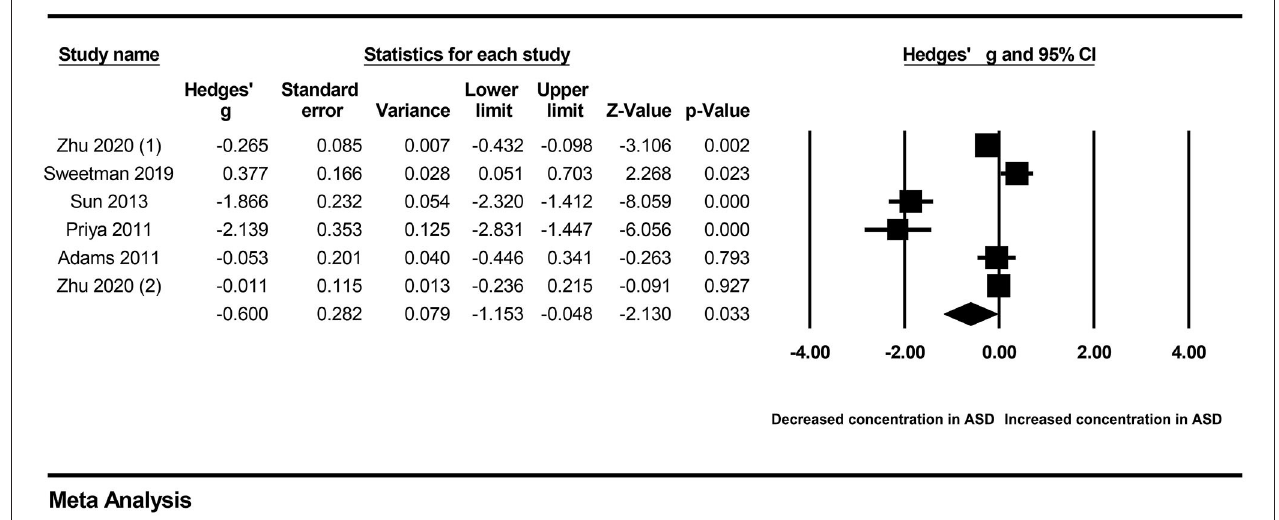
FIGURE 2 | Forest plot for the random-effects meta-analysis.